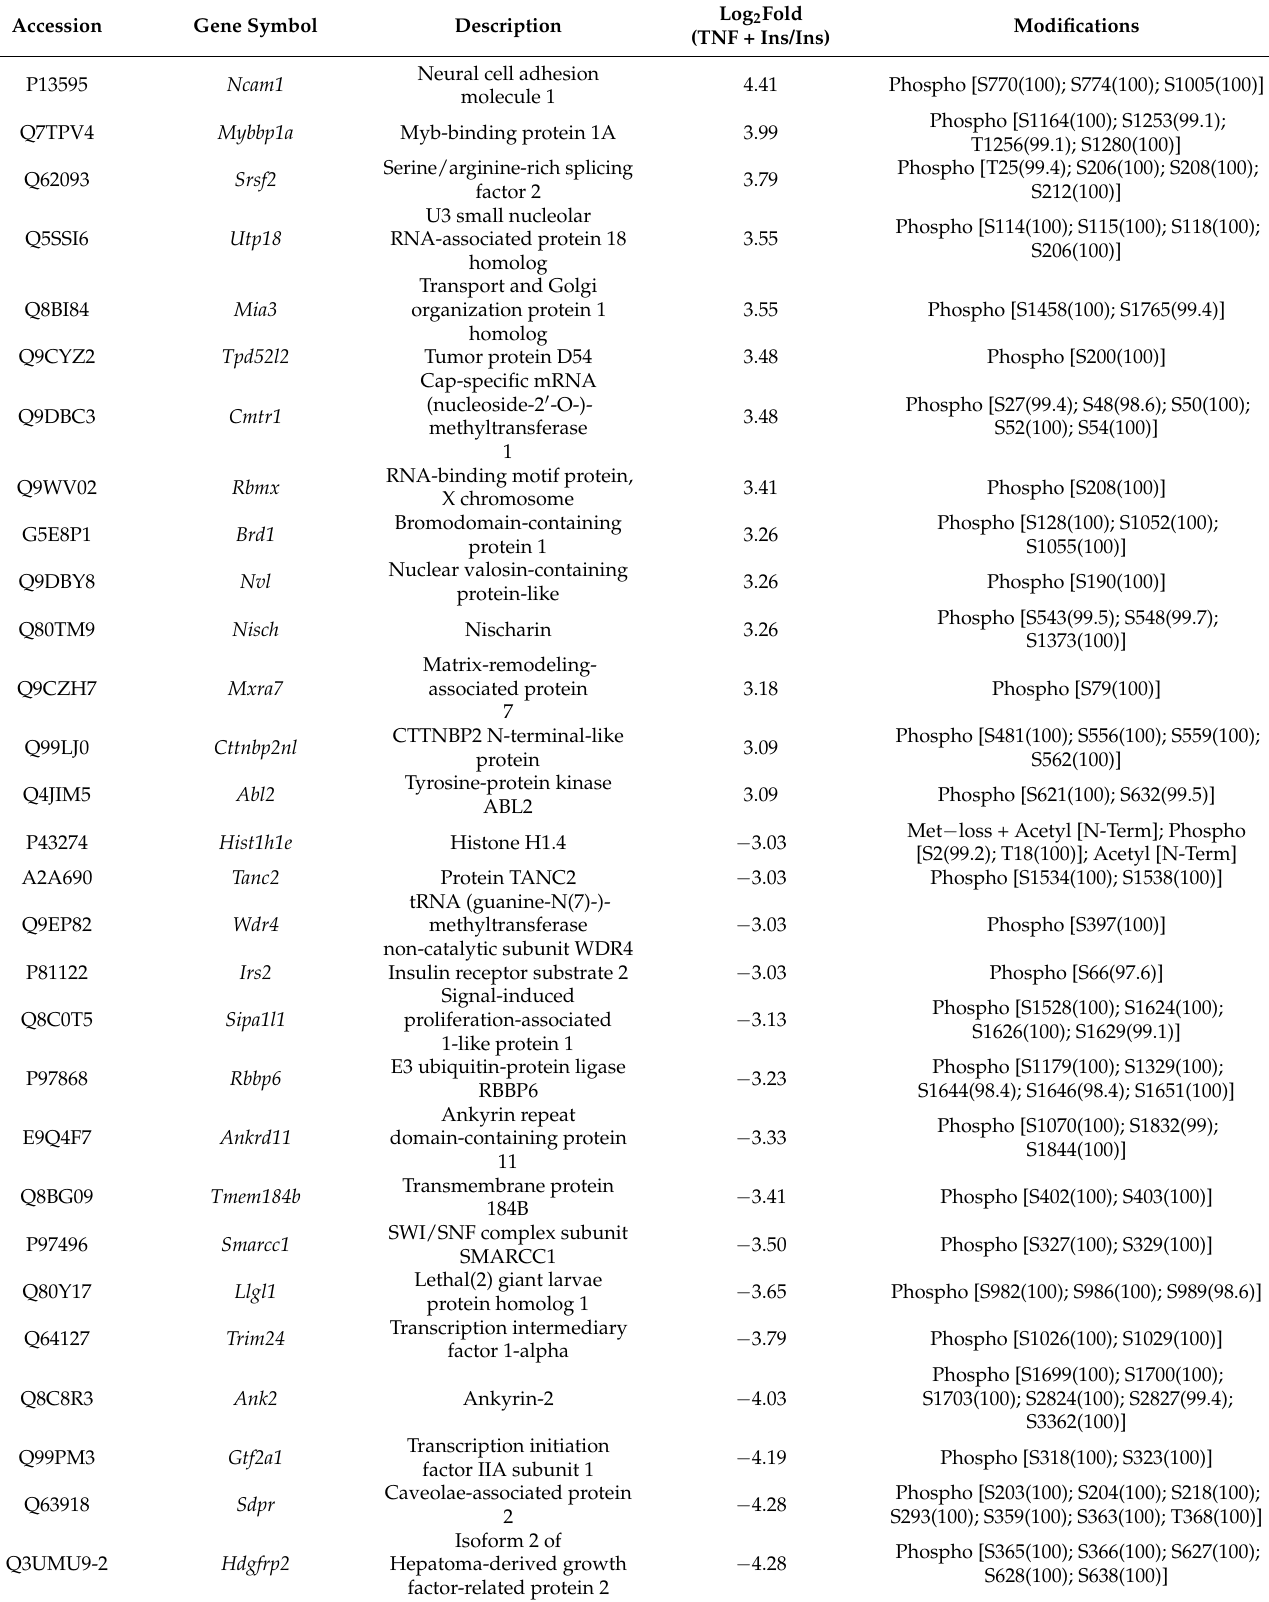
Table 2. Significantly changed phosphoproteomes according to tumor necrosis factor (TNF)- α - induced insulin-resistant